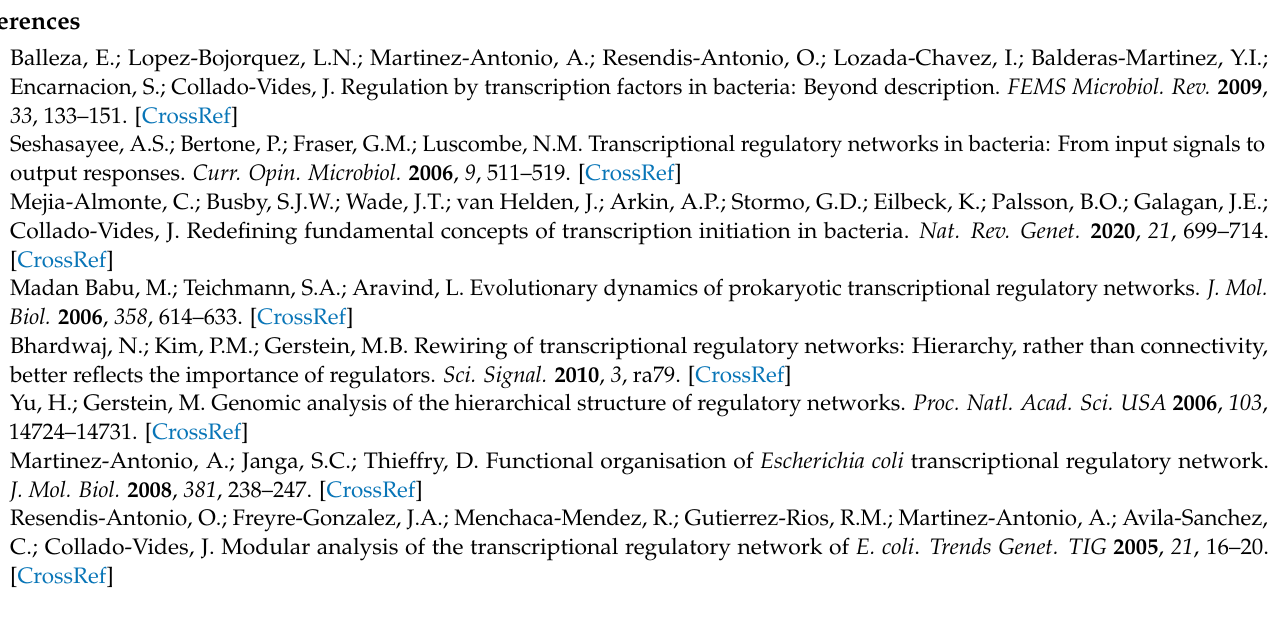
with TRN. Figure S9: Comparison of spatial distances between gene pairs in FFL edges with TRN. Figure S10: The distribution of standard deviation (SD) of spatial distance within SIMs (violin plot) and its comparison with that of TRN (red dashed line). Supplementary Data: The